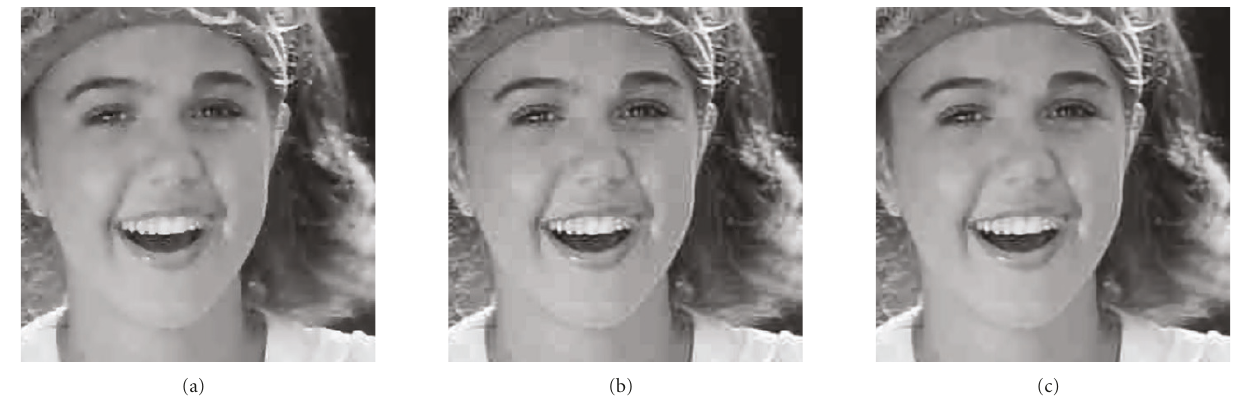
Figure 6: The cutouts of the girl sequence processed using the three methods: (a) first artifact reduction then resolution upconversion; (b) first resolution upconversion then artifact reduction; (c) the proposed